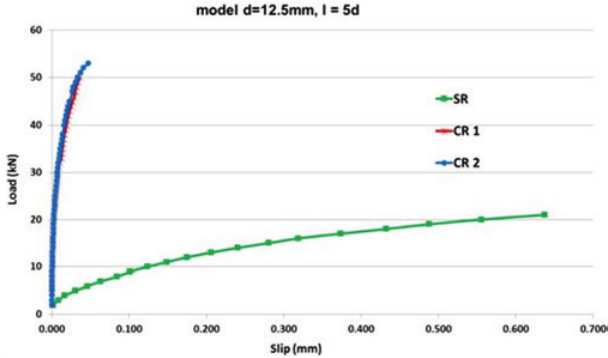
Figure 19 Load- slips, models: 16-7.5-0; 16-7.5-1; 16-7.5-2; 16-7.5-3